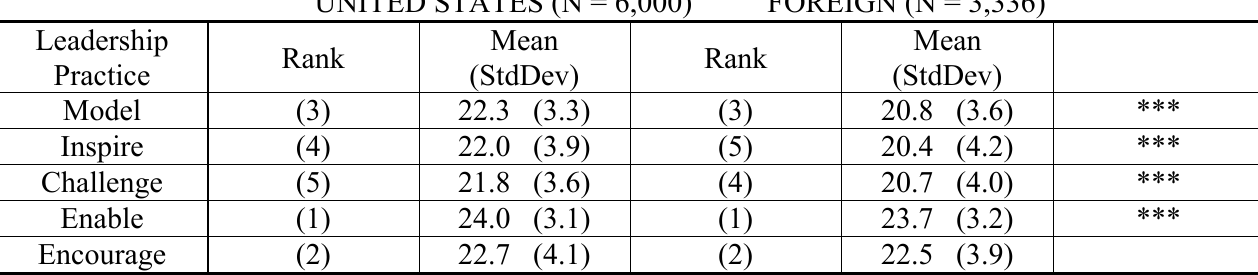
Table 5a. Comparisons between Respondents in the United States and Outside the United States [Foreign] (Self).